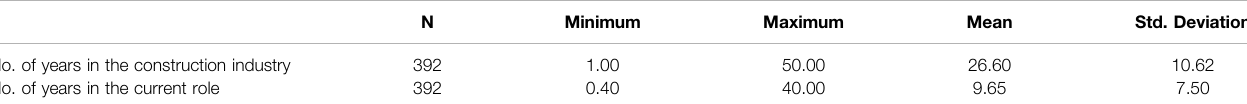
TABLE 4 | Number of years worked descriptive statistics.